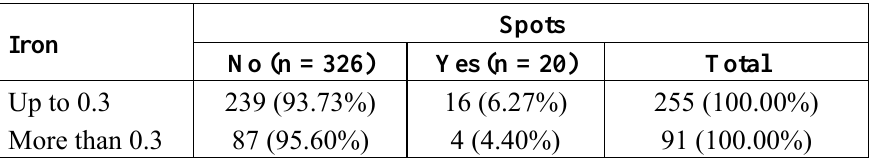
Table 5. Number (%) of subjects with and without spots in accordance of iron content in water, Caapiranga, AM, Brazil, 2011.